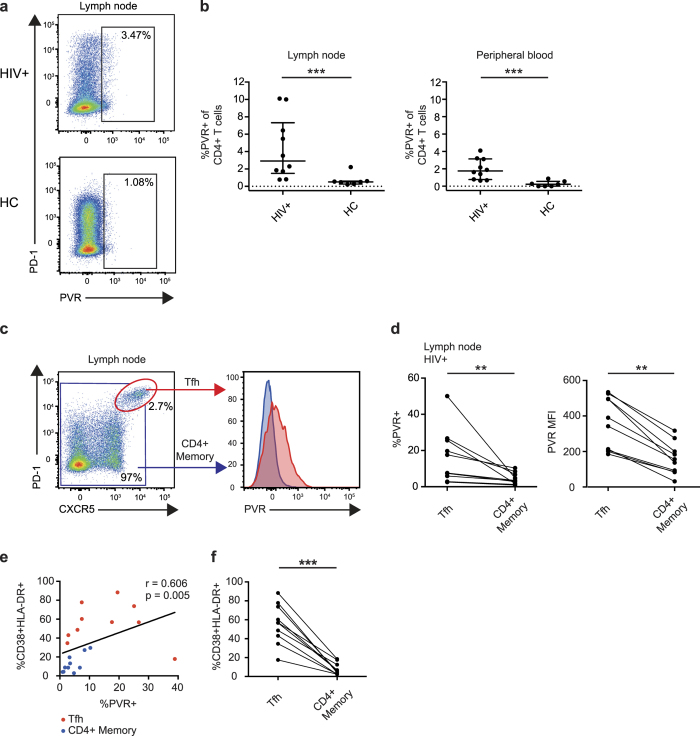
PVR expression on CD4+ T cells in peripheral blood and lymph node.(a) Gating strategy for PVR+ cells of total CD4+ T cells from a representative HIV+ and healthy control (HC) subject. (b) Frequency of PVR+ cells of CD4+ T cells in HIV+ (n = 10) and HC (n = 7) subjects in lymph node and peripheral blood. (c) Gating strategy for PVR expression on T follicular helper (Tfh) cells and histogram showing PVR expression of Tfh cells (red) and memory CD4+ T cells (blue). (d) Frequency of PVR+ cells of Tfh cells versus memory CD4+ T cells in lymph nodes of HIV infected subjects (n = 10). (e) Correlation analysis of the frequency of CD38+HLA-DR+ cells versus frequency of PVR expression on Tfh cells (red) and CD4+ memory T cells (blue). (f) Comparison between the frequency of CD38+HLA-DR+ cells of Tfh versus CD4+ memory cells in the lymph nodes from HIV infected subjects (n = 10). The Mann-Whitney test was used for comparisons between two groups. The Wilcoxon matched-pairs signed rank test was used to compare paired samples. The Spearman non-parametric test was used for correlation analysis. **P < 0.01 and ***P < 0.001.